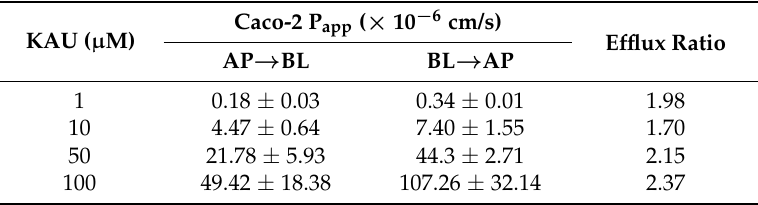
Table 5. Permeability of KAU in Caco-2 cell monolayer (mean ± SD, n =